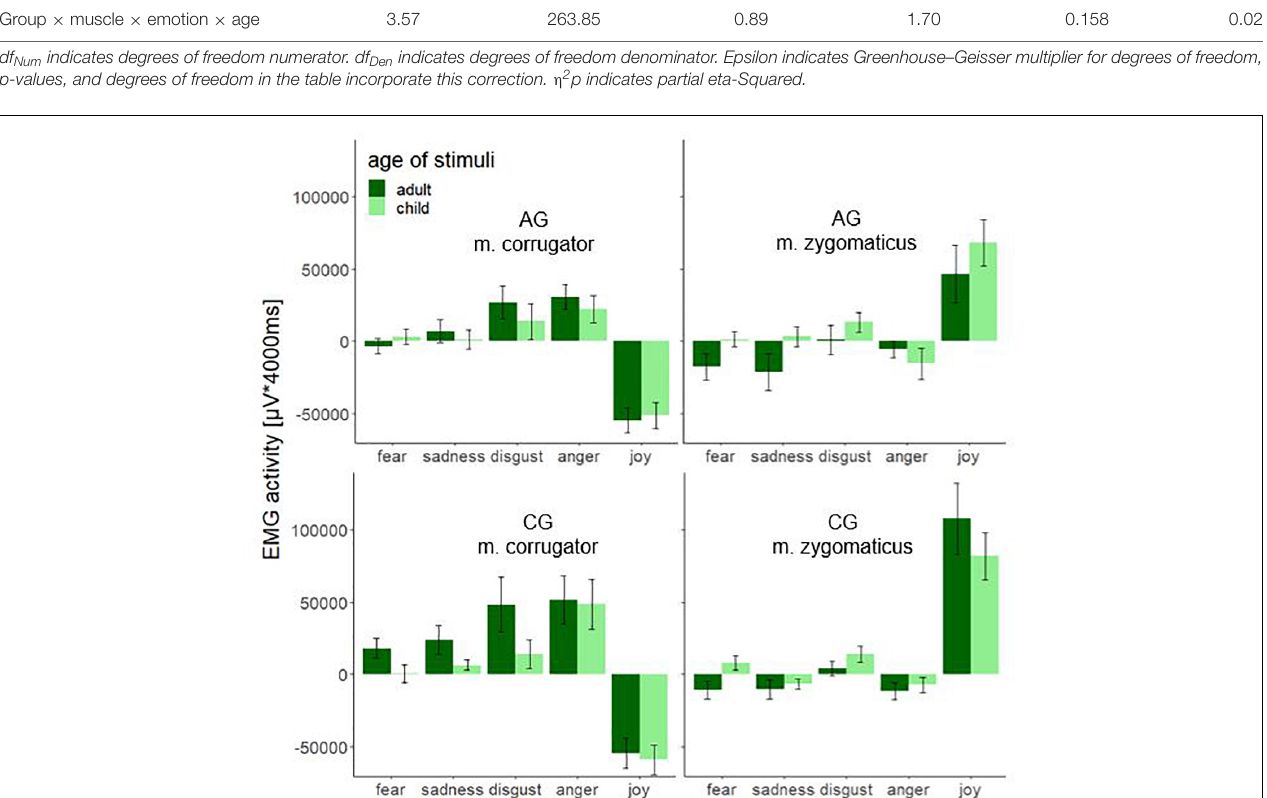
Emotion × age Group × muscle × emotion